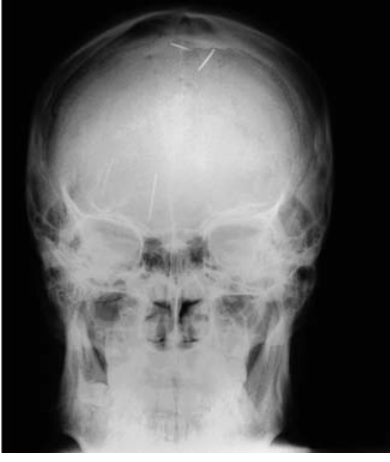
needles.Figure 1. Plain X-ray of the